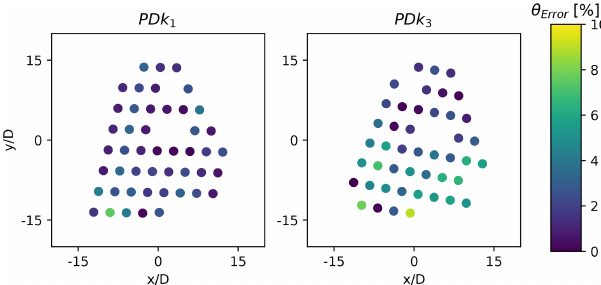
Figure 16. Effect of wind direction on relative turbine orientation error between LES calculations and field SCADA measurements for the cases PDk 1 and PDk 3 . Missing data points correspond to missing SCADA